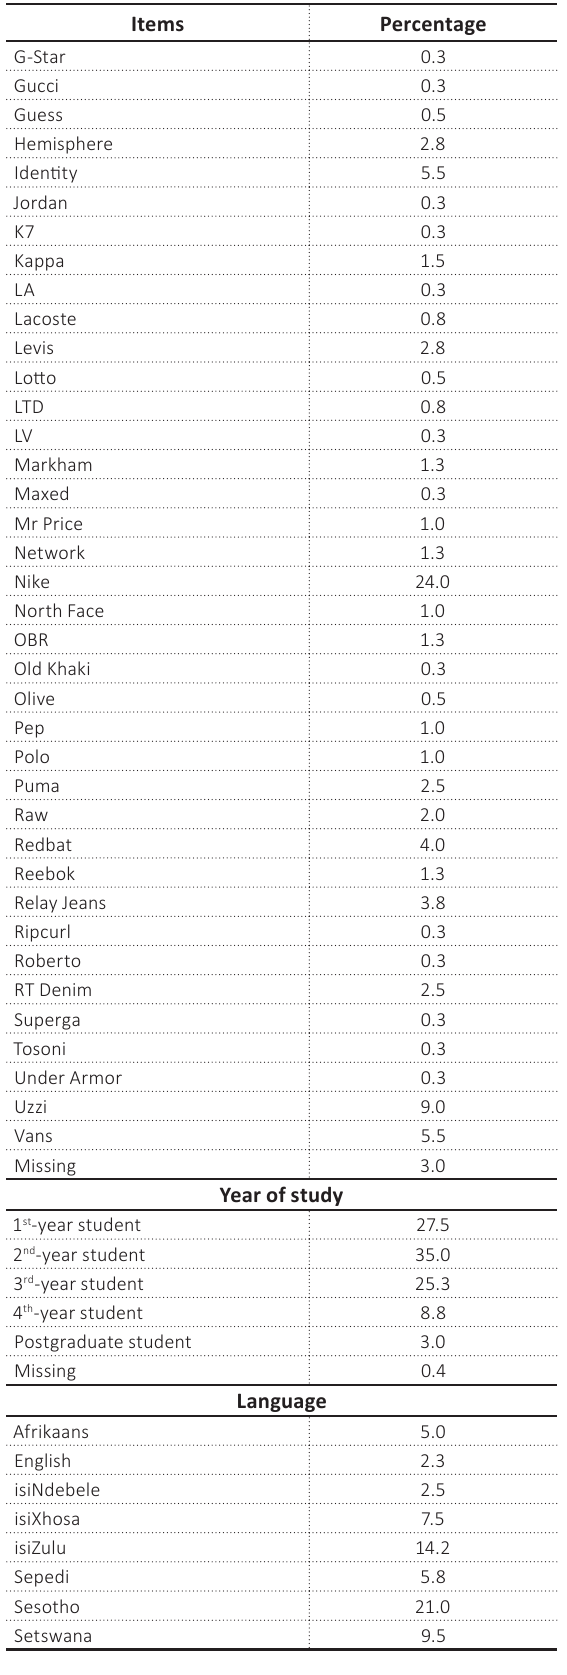
Table 1 (cont.). Sample profile